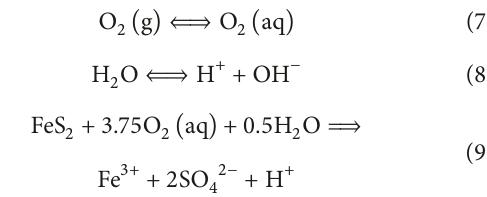
Table 1: Types of reactive transport system. Homogeneous Heterogeneous Paradigm Fast Slow Fast Slow (Equilibrium) (Kinetic) (Equilibrium) (Kinetic) Tank √ Canal √ √ River √ √ √ Aquifer √